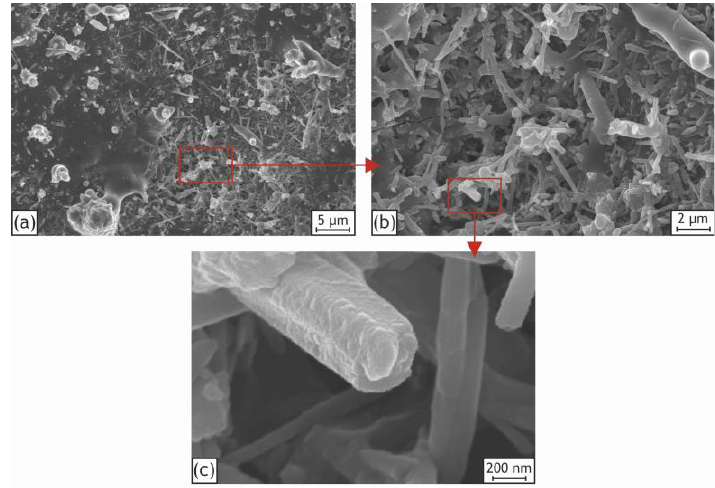
Figure 4. High-magnification SEM images of H40 sample ( a ) with details of the nanoparticles agglomerates ( b ) and HNTs themselves ( c ).